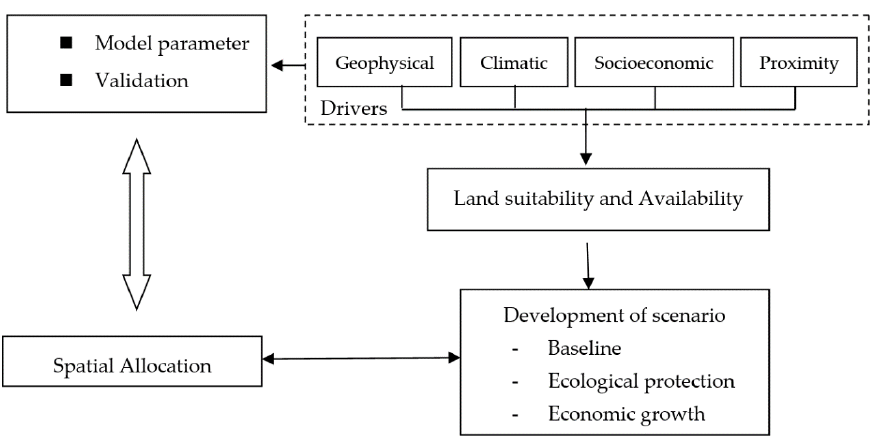
Figure 3. DLS model functioning framework